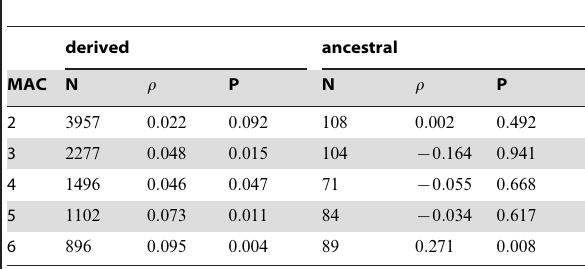
Table 2. Correlation between the NC statistic and PolyPhen2